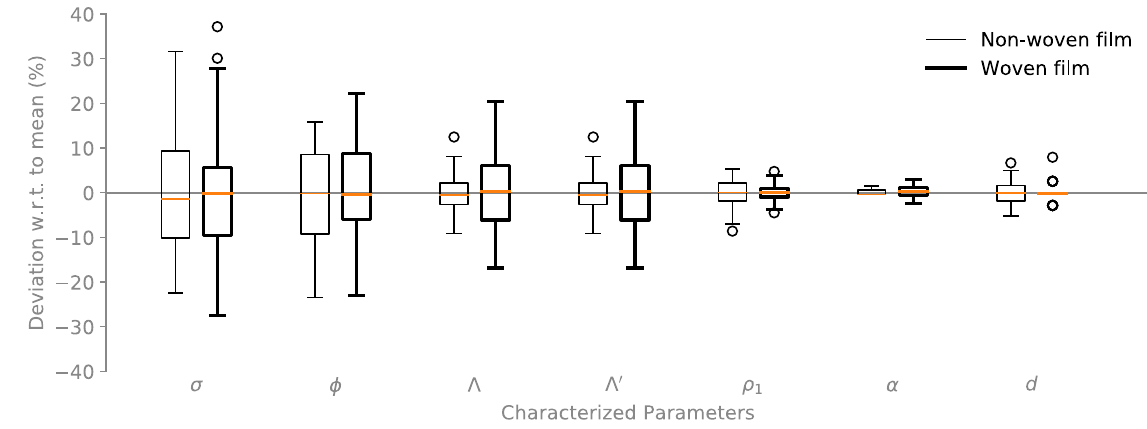
Figure 11. Spread of the JCA parameters and thickness for both facings. The orange line marks the median, outliers are represented with circles and the box spans between the fi rst and third quartiles. Thin lines correspond to the non-woven facing, thick ones to the woven fi lm.